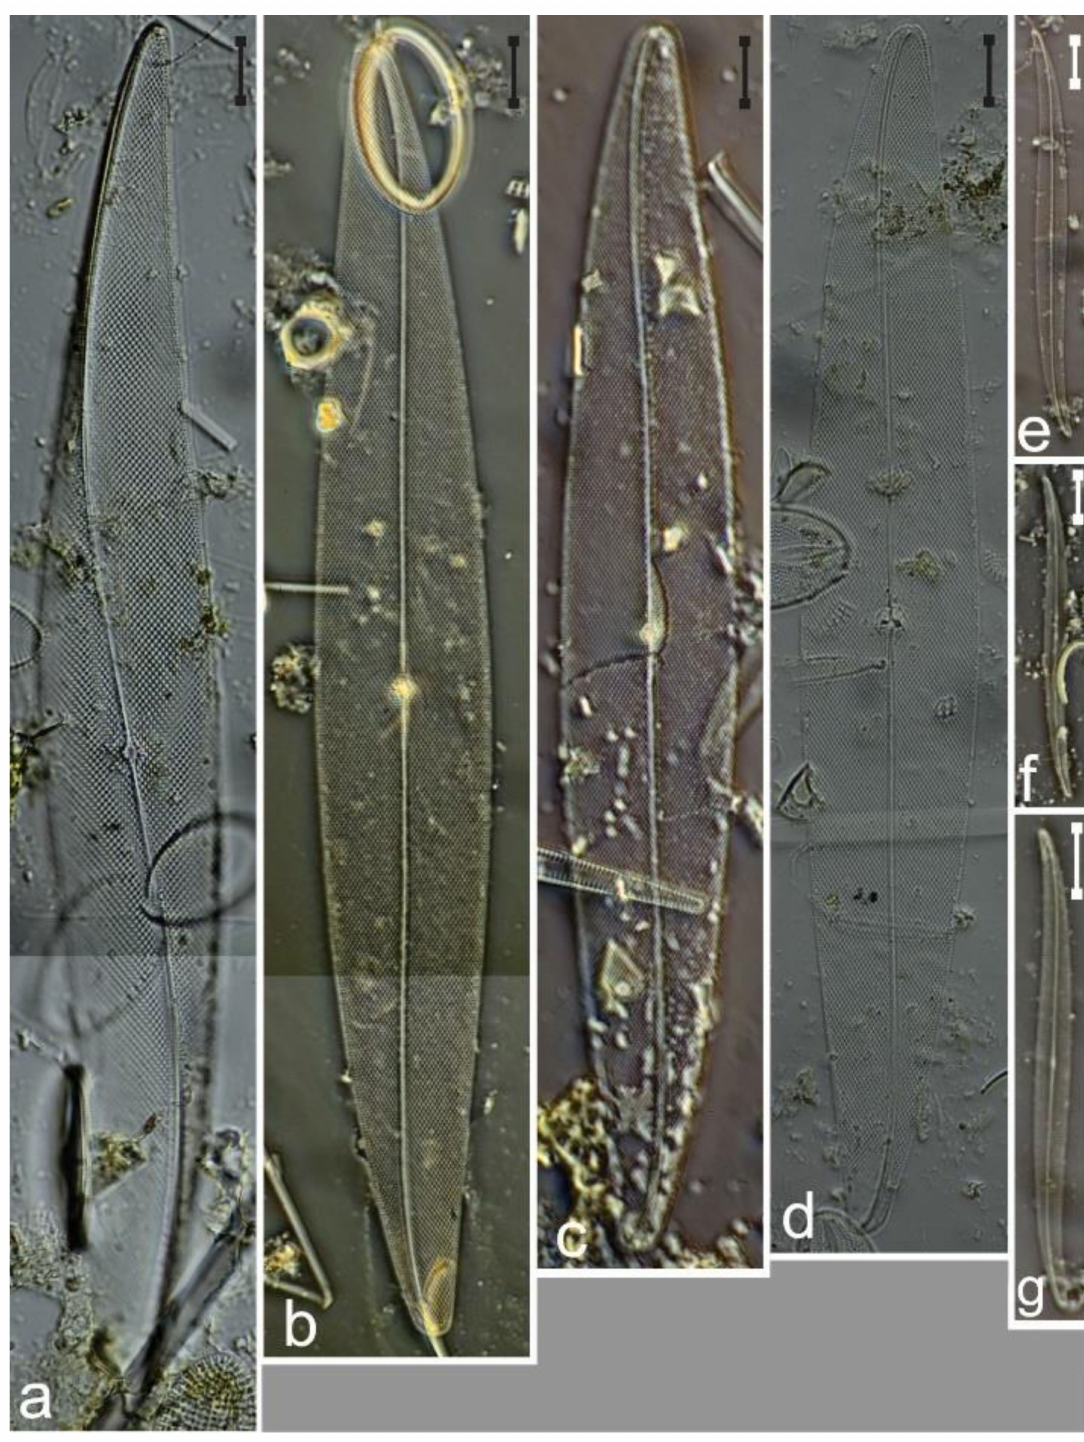
Figure 41. ( a ) Pleurosigma formosum ; ( b – d ) P. rigidum ; ( e – g ) Gyrosigma parvulum . Scale bar = 10 µ